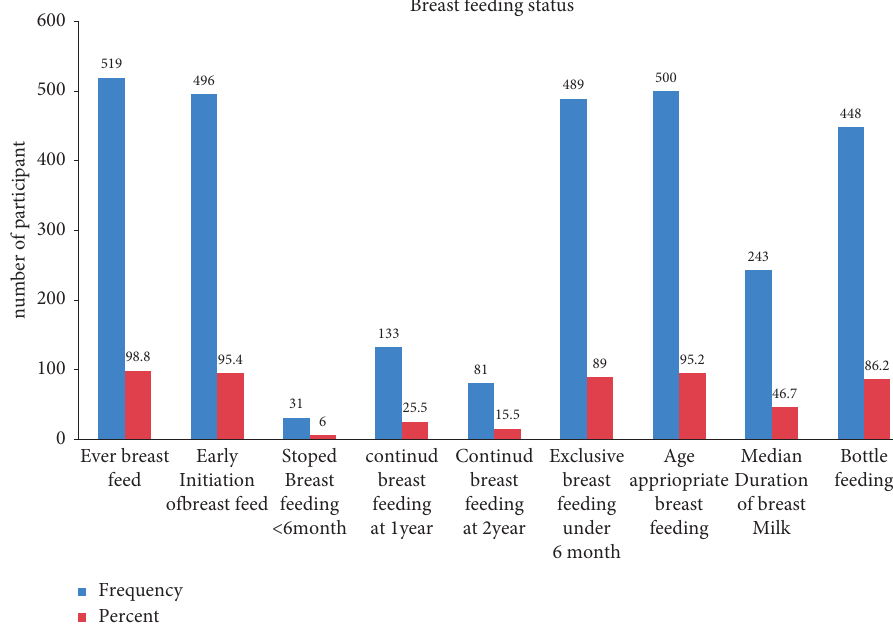
Figure 4: Mothers’ breastfeeding status indicators of 6–23-month children in Shashemene Oromia, Ethiopia, 2020. BF: breastfeeding. EBF: exclusive breast feeding.